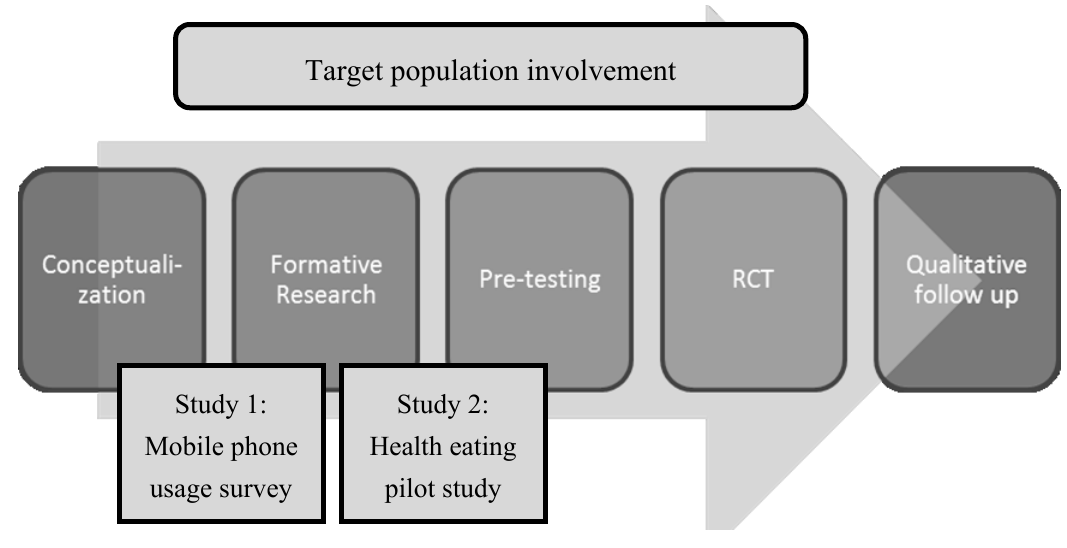
Figure 1. The mHealth Development and Evaluation Framework